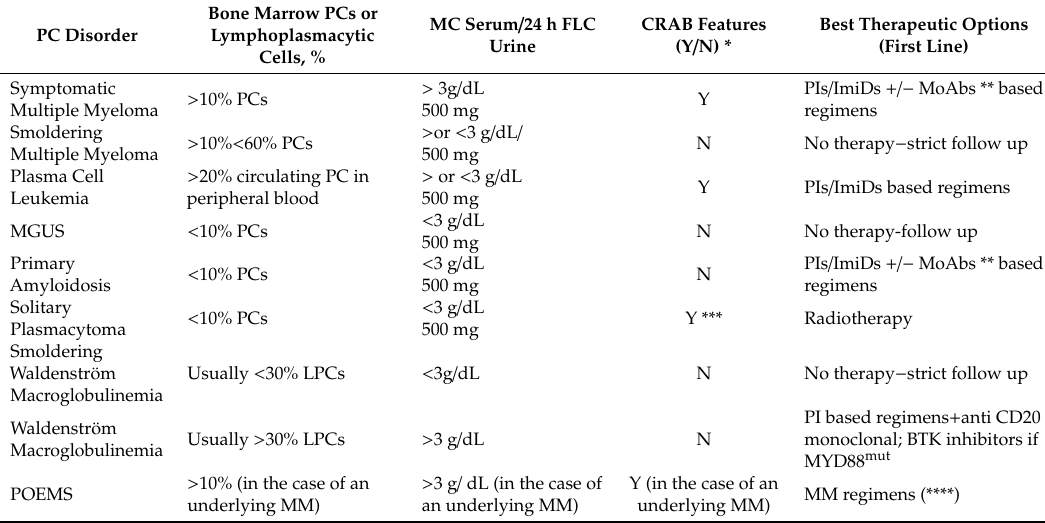
Table 1. Clinical features and best therapeutic options of PC